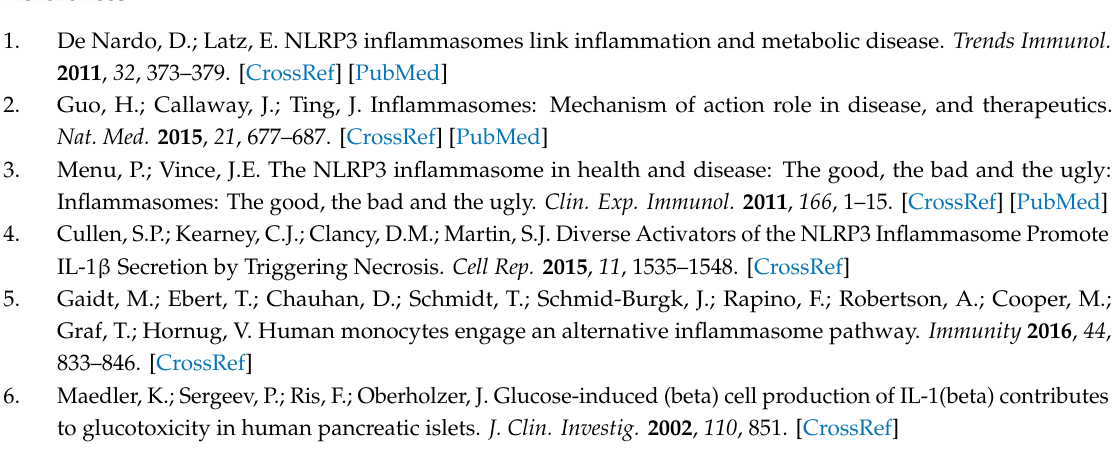
Figure S1: Blood beta-hydroxybutyrate ( β -OHB) following ketone or placebo drink ingestion disaggregated by sex, Figure S2: Median fluorescence intensity (MFI) representative of active caspase-1 in human monocytes as quantified by flow cytometry disaggregated by sex, Figure S3: Secreted cytokines from LPS-stimulated whole-blood cultures disaggregated by sex, Figure S4: Plasma inflammatory cytokines disaggregated by sex, Figure S5: Plasma inflammatory cytokines with individual participants color